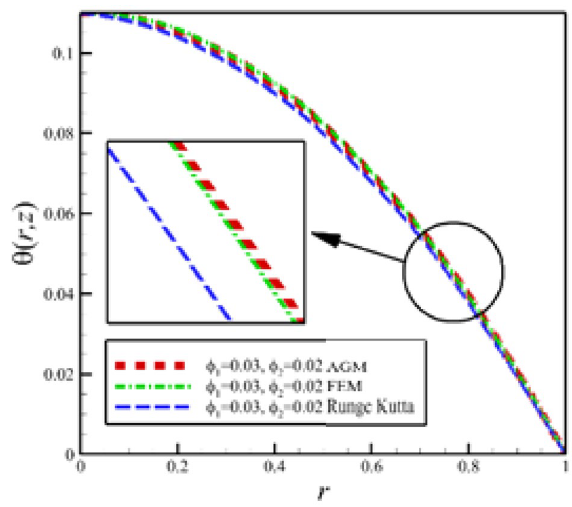
Fig. 9 Percent differences between AGM and FEM,